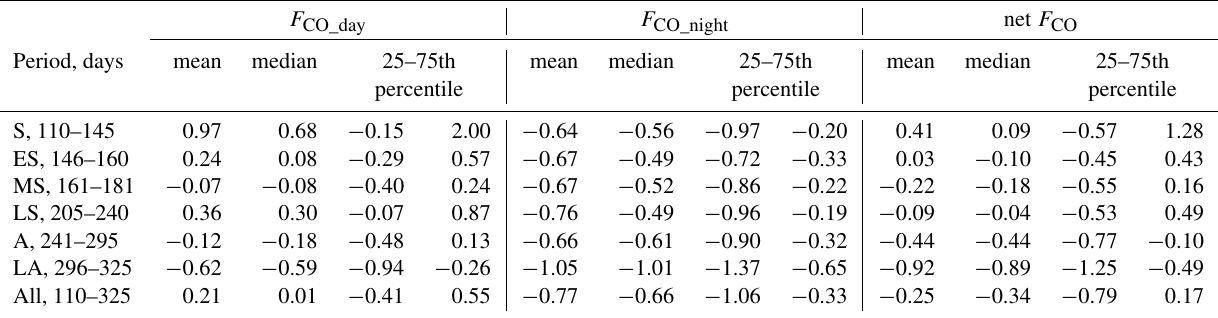
Table 1. Mean, median and 25–75th percentiles of the CO fluxes ( F CO , nmolm − 2 s − 1 ) measured in a read canary grass (RCG) crop at Maaninka. The fluxes are separately calculated for daytime ( F CO_day , sun elevation, h sun >0) and night-time ( F CO_night , h sun <0) and as a net flux over all F CO data (net F CO ) for the six measurement periods (S is spring, ES is early summer, MS is midsummer, LS is late summer, A is autumn, LA is late autumn) and over the full measurement period (All) from April to November